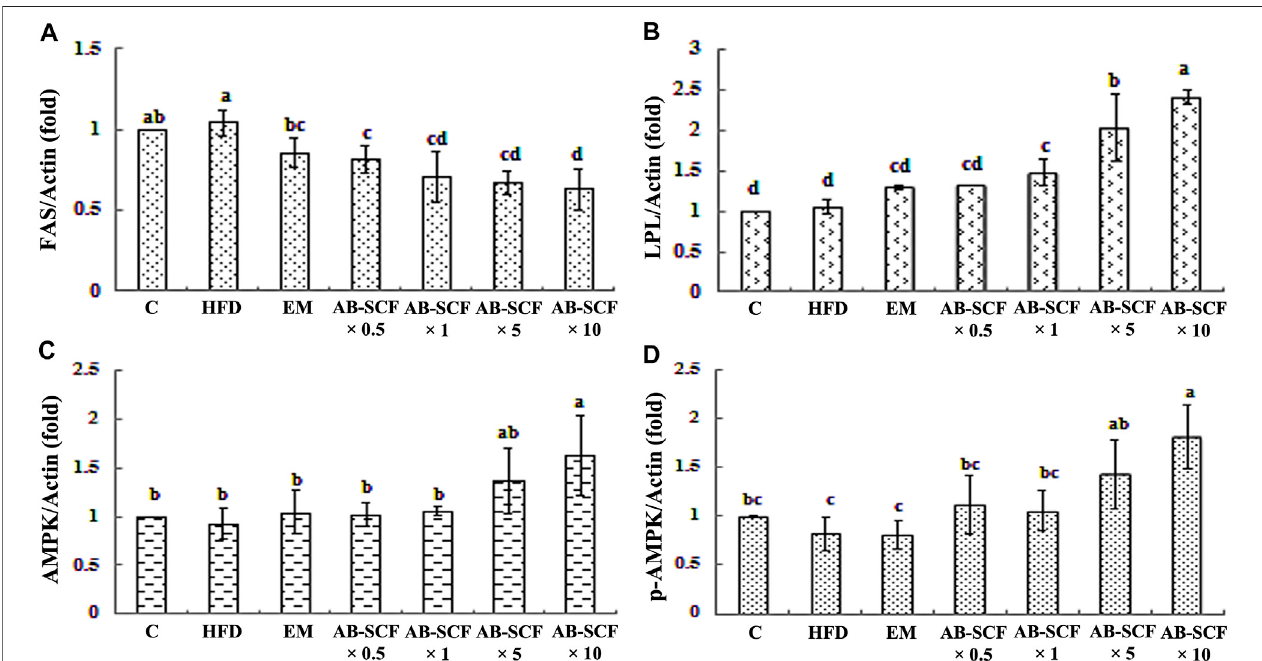
FIGURE3| EffectsofAB-SCFontheexpressionofFAS,LPL,AMPK,andp-AMPKinthelivertissues. (A) FAS,Fattyacidsynthase; (B) LPL,Lipoproteinlipase; (C) AMPK, Adenosine-monophosphate-activated protein kinases; (D) p-AMPK, phosphorylated-AMPK. The expression of β -actin was used as loading control. Relative protein expressions were quanti fi ed densitometrically with an AlphaImager 2200, and processed using AlphaEaseFC software in referring to the β -actin. HFD, high-fat diet; EM, Tween 80/Span 80 (cid:2) 5:1 v/v, diluted water to 5%; AB-SCF, supercritical fl uid extracted aldlay bran. C, a blank control group fed with standard chow diet and water; HFD, a high fat diet induced hyperlipidemic group fed with water; EM, a high fat diet induced fed with the emulsi fi er of AB-SCF; Experimental groups were induced with HFD and administrated AB-SCF/emulsi fi er with a dose-ascending manner, i.e., AB-SCF × 0.5, 30.84 mg/kg/BW; AB-SCF × 1, 61.67 mg/kg/BW; AB- SCF × 5,308.35 mg/kg/BW;AB-SCF × 10,616.70 mg/kg/BW.Dataaremean ± SD, n (cid:2) 10hamstersineachgroup.Meanswithdifferentlettersinthesamecolumnwere signi fi cantly different at p < 0.05 as statistically analyzed by Duncan ’ s multiple range tests.